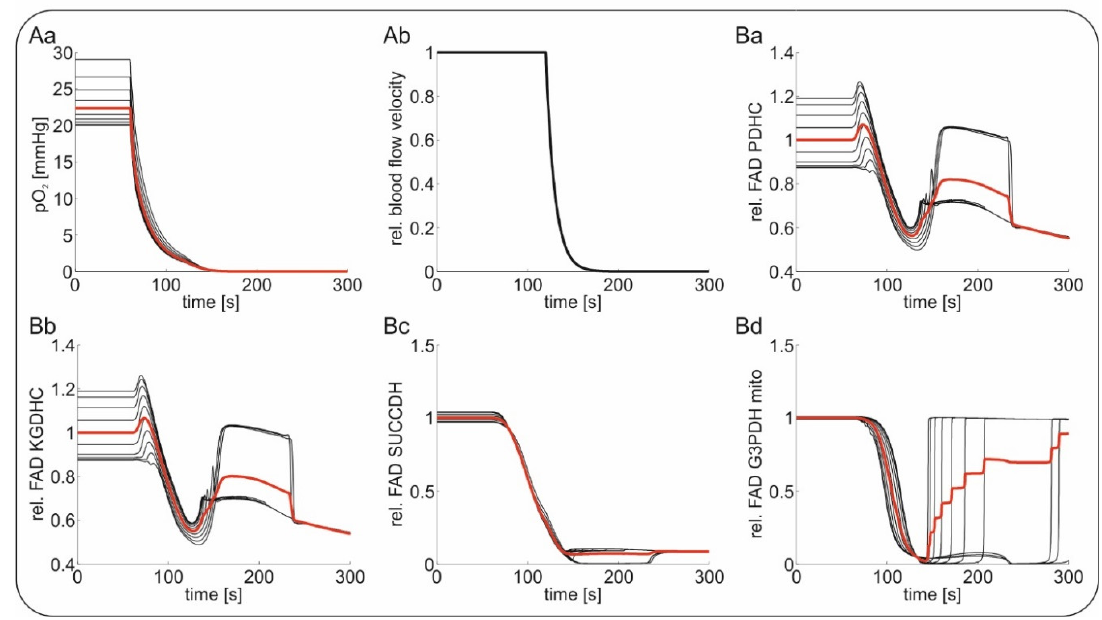
Figure 6. Stimulation of in vivo Flavin adenine dinucleotide (FAD) fluorescence during hypoxia and subsequent global ischemia-induced terminal spreading depolarization (SD); capillary tissue oxygenation (pO 2 ) was decreased from 30 mmHg to 0 mmHg at t = 60 s followed by further substrate depletion during terminal SD. Red traces indicate average values of the black traces indicating the different layers around the vessel. ( Aa ) The course of the decrease in oxygen during simulated hypoxia mimicking in vivo experiments; ( Ab ) followed by maintained hypoxia, the relative blood flow velocity in the tissue was stopped, simulating the events of global ischemia and terminal SD; simulated relative changes signal of FAD bound to pyruvate dehydrogenase (PDHC, Ba ); to α -ketogluterate dehydrogenase (KGDHC, Bb ); to succinate dehydrogenase (SUCCDH, Bc ) and to mitochondrial glycereol-3-phophate dehydrogenase (G3PDH, Bd ).